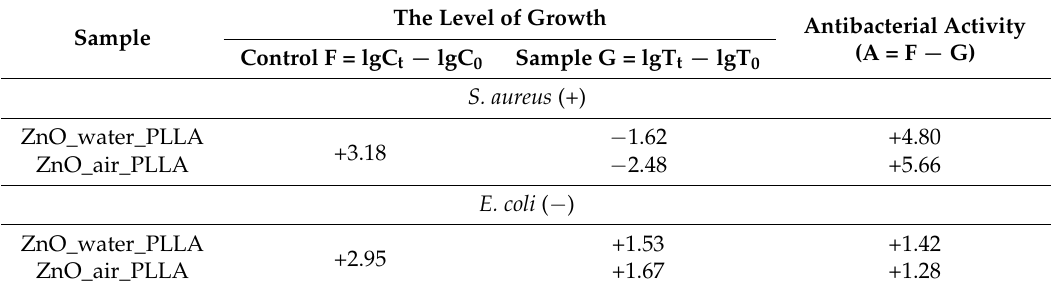
Table 2. Antibacterial activity of prepared samples towards S. aureus and E. coli